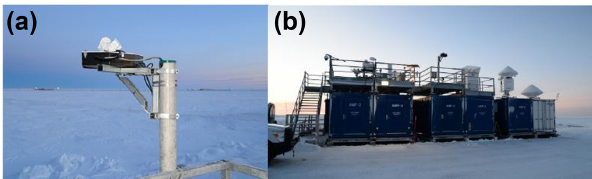
Figure 1. (a) Unshielded MASC configuration at the third ARM Mobile Facility (AMF3), Oliktok Point, Alaska. (b) Ground-level view of the MASC on top of a group of shipping containers. This was the MASC configuration from initial deployment in February 2015 through 21 August 2016. Image courtesy of the US Depart- ment of Energy ARM user facility.